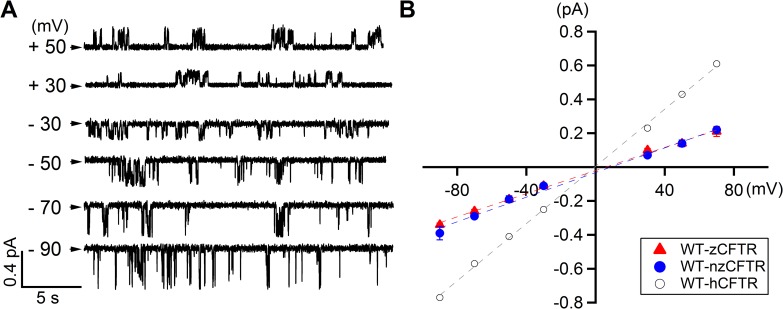
Single-channel conductance of phosphorylated zCFTR.(A) Single channel recordings of WT-zCFTR recorded at different membrane potentials from + 50 mV to—90 mV. In addition to smaller channel conductance, multiple sub-conductance levels were often observed. Arrowheads indicate the closed-channel current level. (B) Single-channel I-V relationship of zCFTR shows smaller conductance and inward-rectification. The single-channel I-V relationship of WT-hCFTR [41] is shown in circles for comparison. The I-V relationships of both codon optimized zCFTR (WT-zCFTR, red triangle) and native form zCFTR (WT-nzCFTR, blue dot) are nearly identical. Linear-fittings (dashed lines) of the I-V relationship show that the overall conductance is 8.4 pS for WT-hCFTR, 3.4 pS for WT-zCFTR and 3.6 pS for WT-nzCFTR. For each data point, N = 3–10.